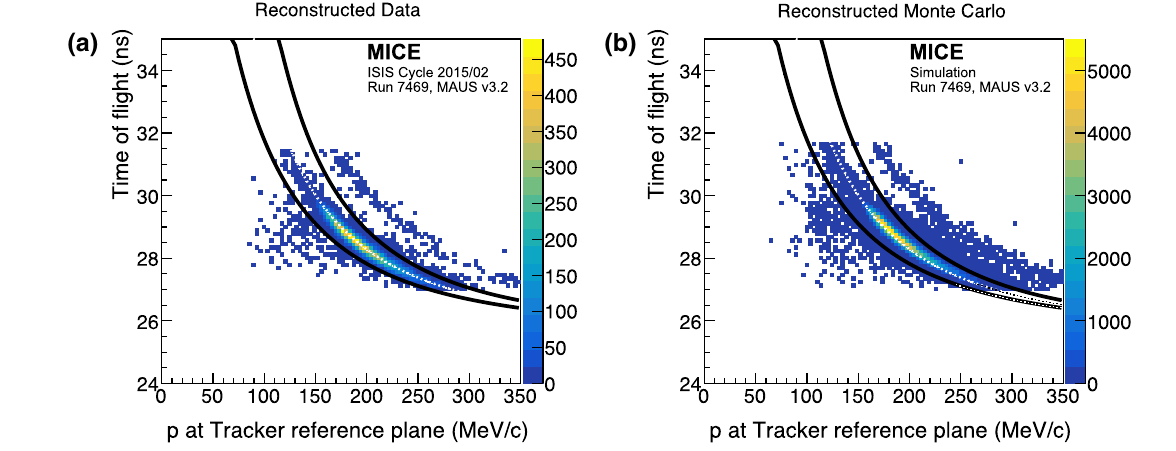
a muon that loses the most probable momentum (20MeV/ c ) between TOF1andthetrackerin a reconstructeddata,and b reconstructedMonte Carlo